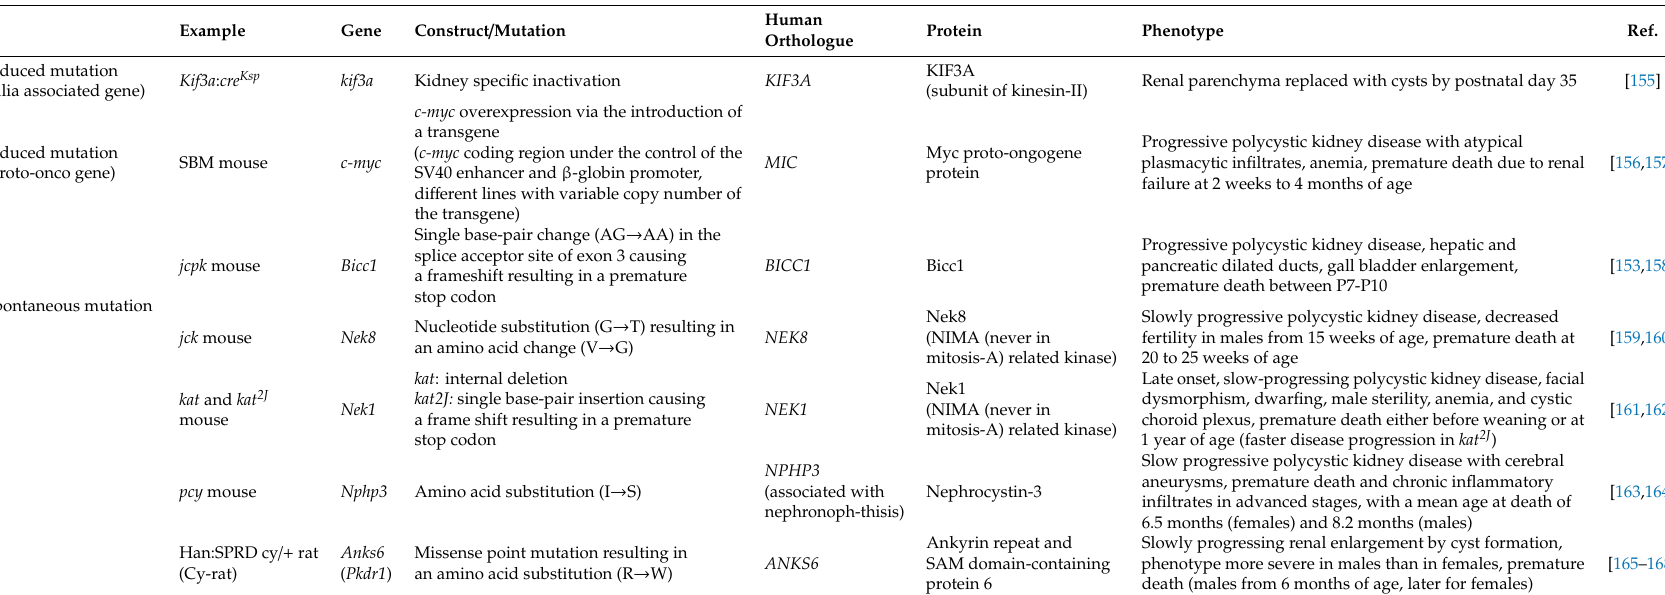
Table 3. Examples of rodent models frequently employed in ADPKD research, in which a phenotype closely resembling ADPKD is caused by mutations in genes other than the PKD genes. Models developing a phenotype rather resembling ARPKD than ADPKD, such as the bpk mouse in which the polycystic phenotype is caused, as in the jcpk model, by a mutation in the Bicc1 gene [153] or the orpk mouse (oak ridge polycystic kidney) carrying a hypomorphic allele of Ift88 [148,154] have not been included in this table. P = postnatal